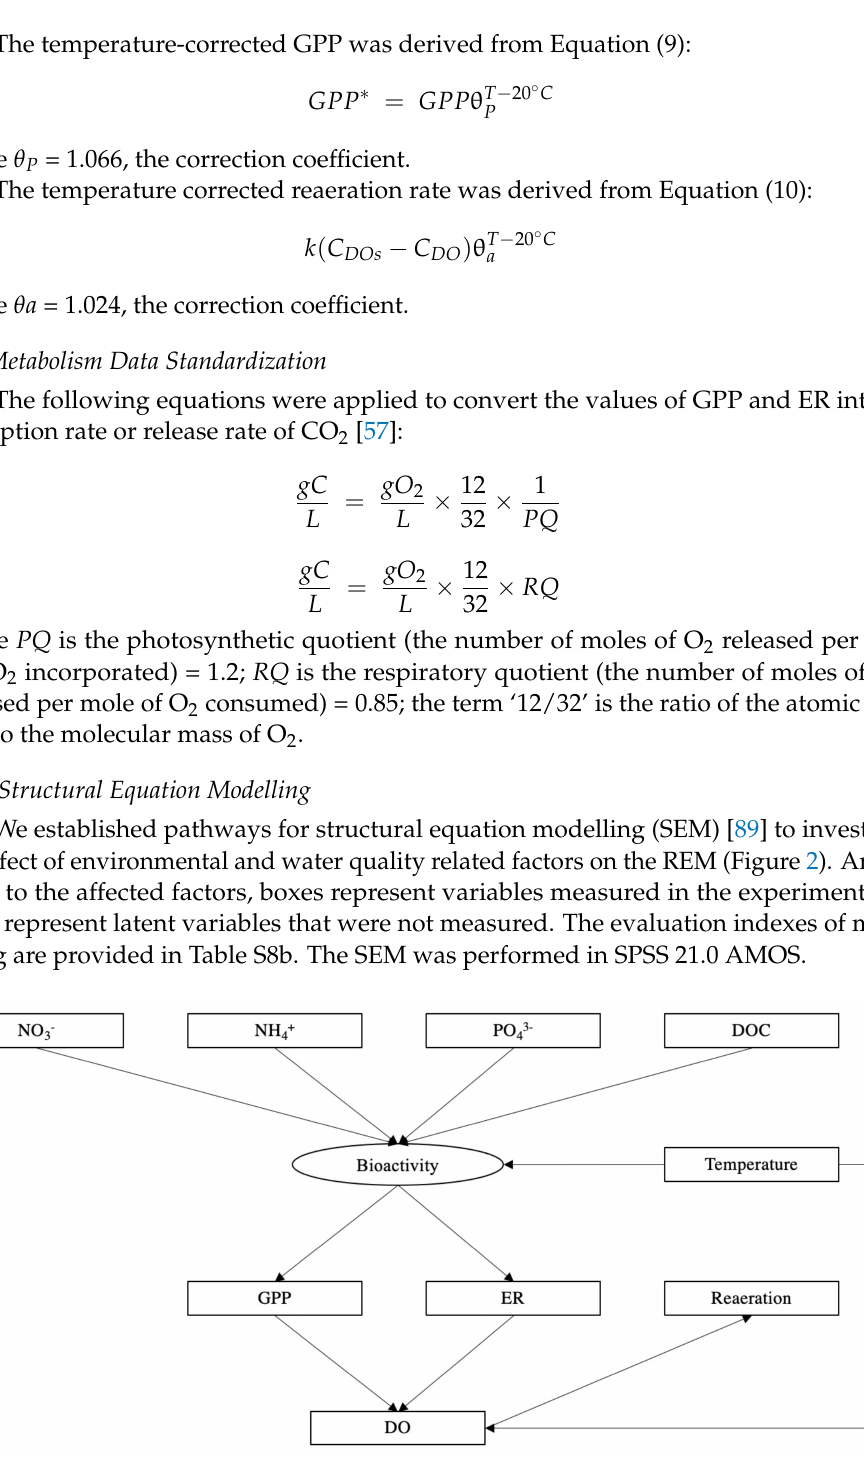
Figure 2. SEM for river metabolism in the study reaches. Variables linked by arrows have causal relationships. The box represents the observed variable; the oval represents the latent